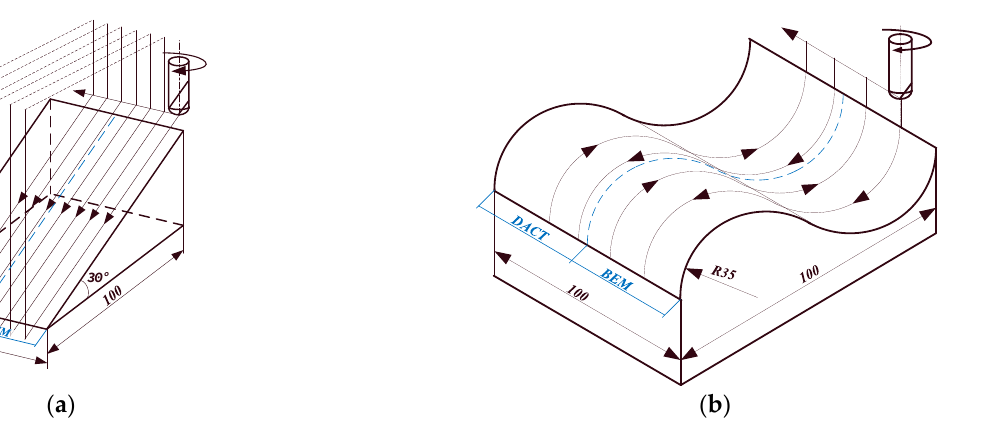
( b ) Figure 16. Machine tool and cutting tools: ( a ) inclined plane; ( b ) concave – convex ruled surface. In addition, a Kister 9171A revolving dynamometer and a VDL-1000E machine were adopted in the test process to collect the cutting force, as shown in Figure 17. DACT BEM Cutting tool Workpiece Machine tool HURCO VMX50Mi Cutting tool Workpiece